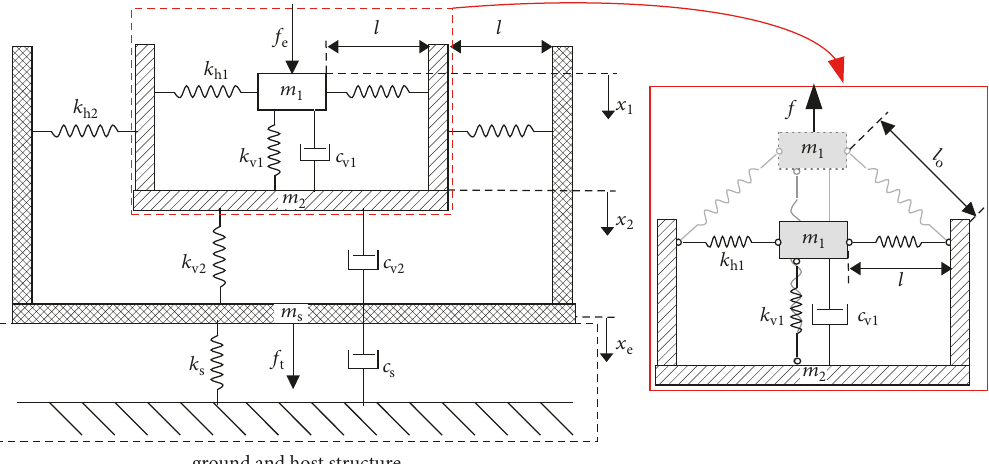
Figure 1: Schematic of a two-stage HSLDS vibration isolation system mounted on a linear flexible base. The mass, 𝑚 1 , is the suspended mass, 𝑚 2 is the mass of the intermediate stage, and